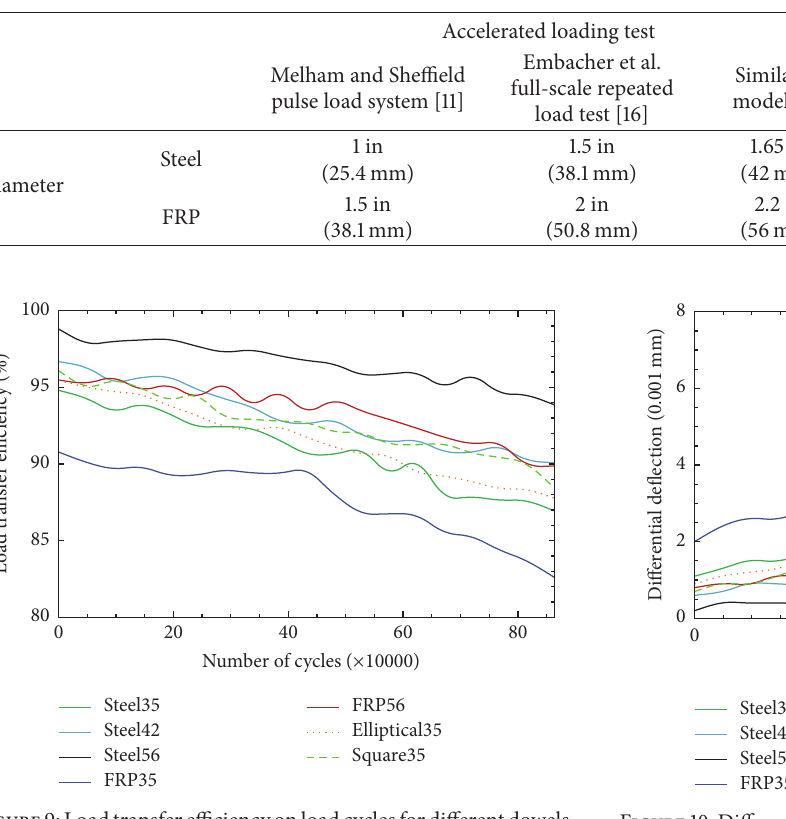
Figure9:Loadtransferefficiencyonloadcyclesfordifferentdowels. Figure 10: Differential deflection on load cycles for different